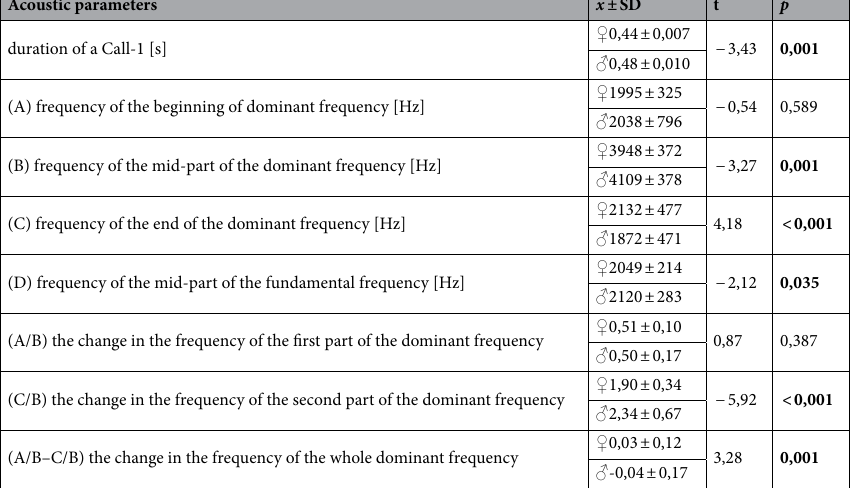
Table 2. T-test for between-sex differences in eight parameters of Call-1, n = 24 individuals (10 females and 14 males), 240 calls.